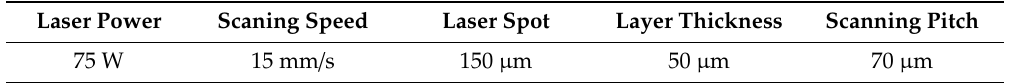
Figure 1. ( a ) Schematic of the self-regulated SLM system, ( b ) Layer-by-layer building procedure, ( c ) “s” style scanning lines of the lower layer and ( d ) scanning lines of the upper layer. Table 1. The SLM process parameters.